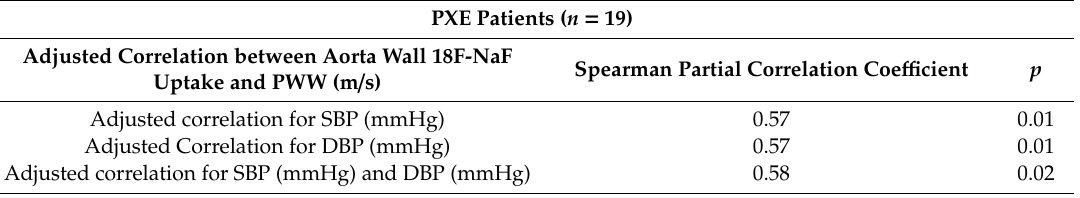
Table 3. Correlation between aorta wall 18F-NaF uptake and PWV adjusted to SBP, DBP and both together.